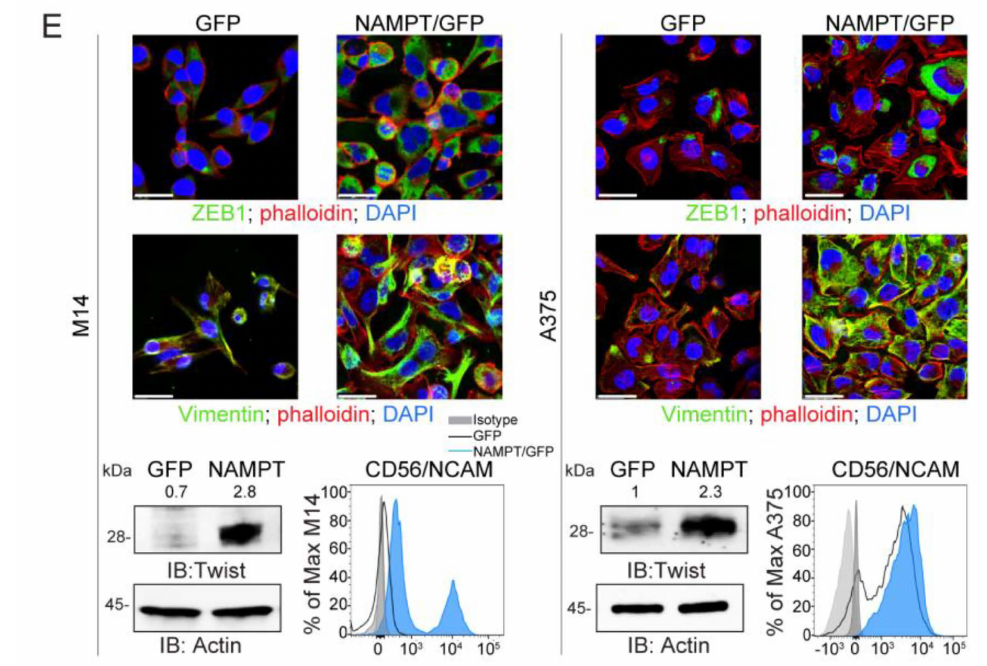
Figure 3. NAMPT over-expression induces a phenotype switch towards invasive and mesenchymal features. ( A ) Representative images ( × 10 magnification) of invasion assay in Matrigel for 24 h of M14 and A375 cell lines comparing NAMPT / GFP and GFP variants. Histograms on the right represent cumulative data of invasion assays (at least 6 independent experiments). Invasion index was calculated as the number of cells penetrated in the presence of the chemoattractant / number of cells penetrated without chemoattractant. ( B ) Gel zymography analysis of cell extracts derived from M14 and A375 NAMPT / GFP and GFP variants. Arrows indicate the most up-regulated metalloproteinase (MMP) activities at molecular weights compatible with MMP-9 (92 kDa), MMP-2 (72 kDa), MMP-1 and MMP-3 (55-45 kDa). Histograms on the right show cumulative data of MMPs activity obtained from gel zymography analysis in both cell lines variants (at least 4 independent experiments, Mann–Whitney test). ( C ) Di ff erential expression of integrin- α 3 (ITG α 3) in M14 and A375 NAMPT / GFP and GFP variants detected by FACS analysis. ( D , E ) qRT-PCR analysis ( D ) or representative confocal (green fluorescence, original magnification 63 × , scale bar: 25 µ m), western blot and FACS analysis, ( E ) showing expression of mesenchymal molecules including TWIST, ZEB1, VIM and NCAM. In qRT-PCR and western blot experiments, expression levels of the analyzed gene / protein were normalized over Actin. In the representative western blot densitometry intensity ratios of Twist bands over actin were reported. Results were obtained from at least 6 independent experiments. Unpaired t test. Data in the Figure are presented as the mean ± SEM. Significance was represented as: * p ≤ 0.05, ** p ≤ 0.01, *** p ≤ 0.001 and **** p ≤ 0.0001. Uncropped Western Blot Images in Figures S9 and